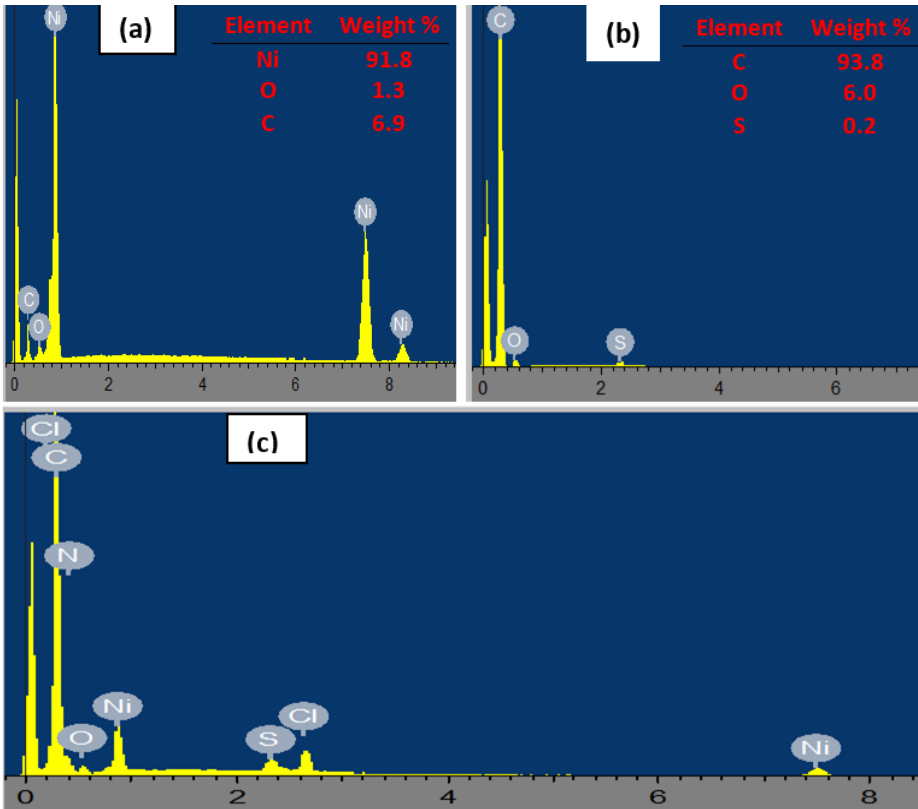
Figure 3. EDX spectra of ( a ) NiNp, ( b ) fMWCNTs, and ( c ) NiPcMWCNTs nanocomposite.